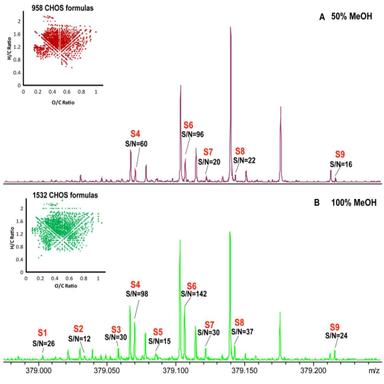
The scale-expanded FTICR mass spectra of sea marine DOM at nominal m/z 379 observed with different spray solvents. (A) 50% MeOH aqueous solution; (B) 100% MeOH. Inserted figures on top left are the Van Krevelen diagrams for CHOS-molecules in sea marine DOM detected by ESI-FTICR-MS. "Sn" denotes the peaks of CHOS-molecules.